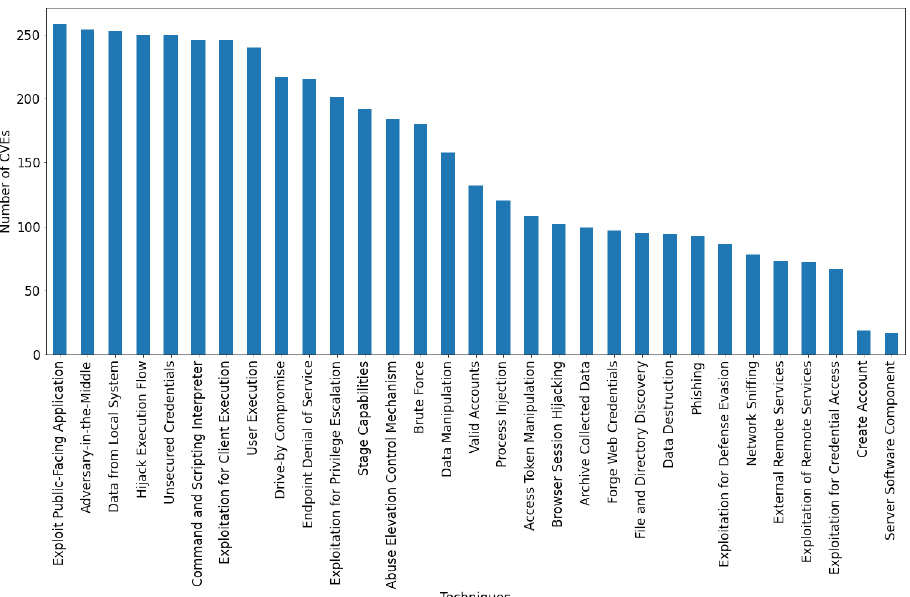
Figure 3. The distribution of CVEs among the 31 considered techniques after data